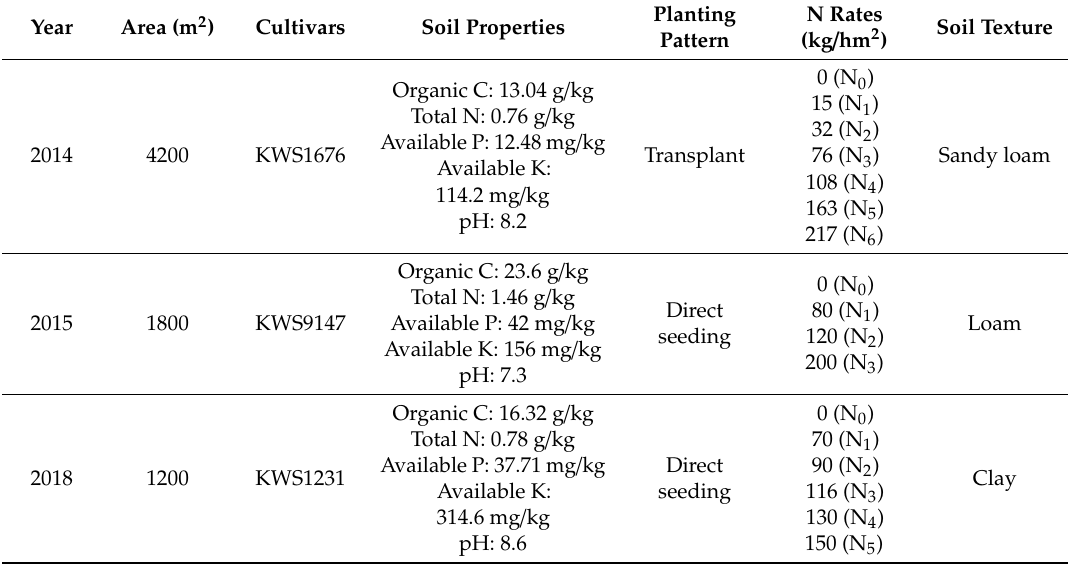
Table 1. Management information of the sugar beet experiment in the three experimental sites.